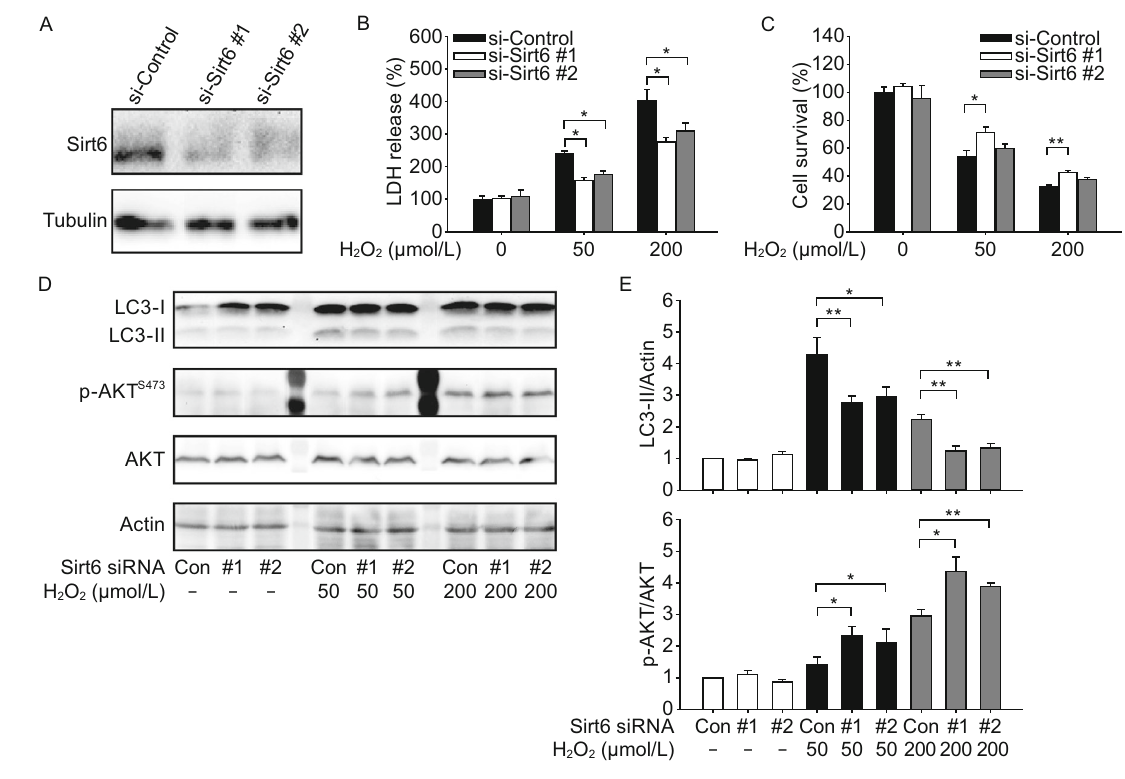
Figure 6. SIRT6 inhibition reduces neuronal cell death and attenuates autophagy after H 2 O 2 treatment. (A) Knockdown of Sirt6 by siRNAs. (B and C) SH-SY5Y cells were exposed to H 2 O 2 for 1 h and then cultured for 24 h after transfection with Sirt6 siRNAs. Cell death was assessed by LDH release assay and cell viability was assessed by CCK-8 assay. (D and E) SH-SY5Y cells were exposed to H 2 O 2 for 1 h and then cultured for 24 h after transfection with Sirt6 siRNAs. LC3 and phosphorylated AKT levels were analyzed by Western blot and quanti fi ed. Bars represent the mean ± SEM from at least three independent experiments. * P < 0.05; ** P < 0.01.